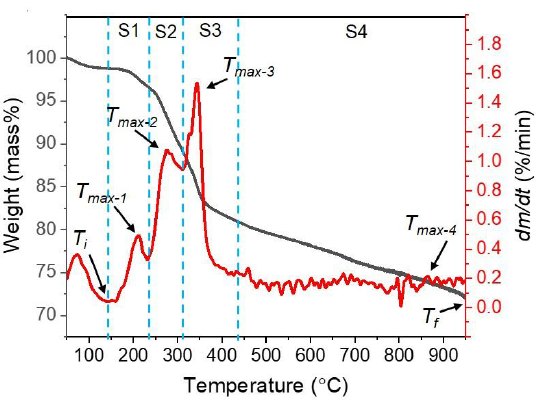
Figure 5. Weight loss and reactivity rate ( dm/dt ) curves of the iron ore-biomass pellet at a heating rate of 10 °C/min.